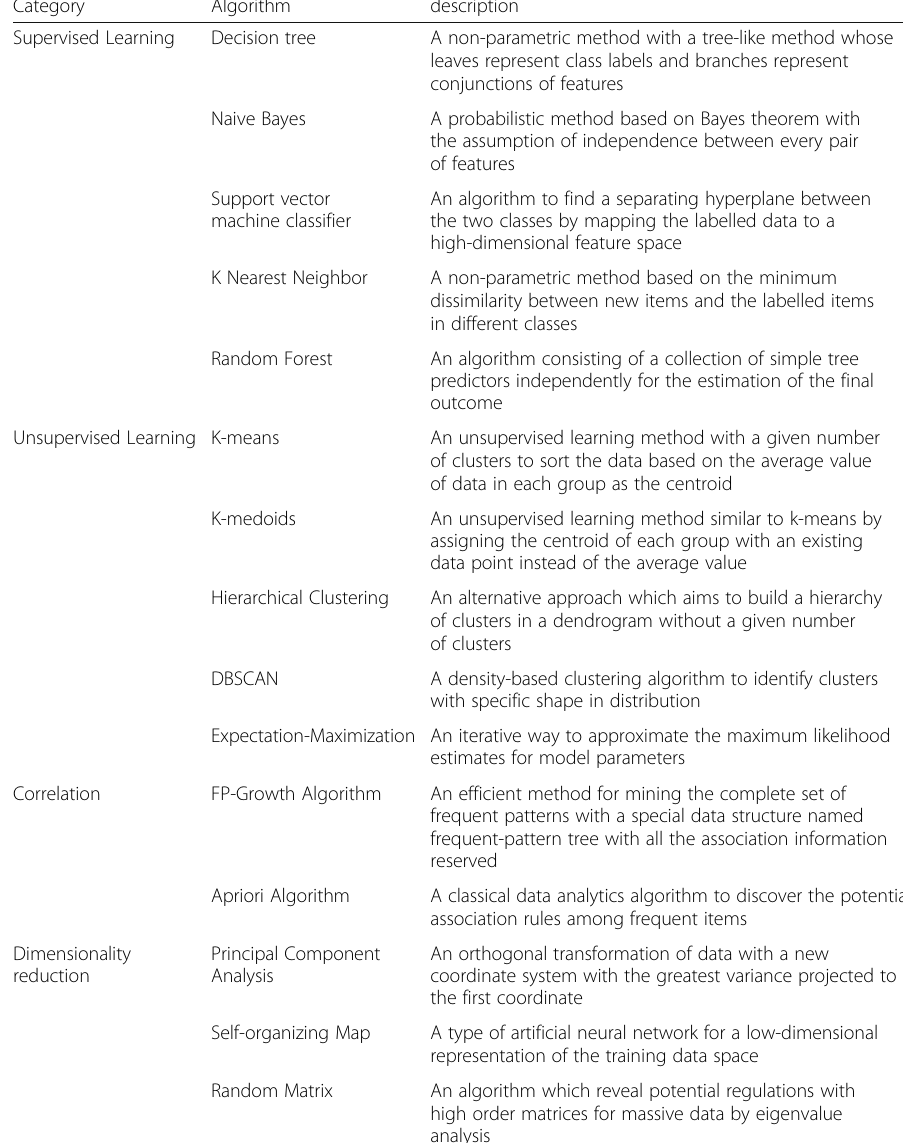
Table 5 Data Analytics